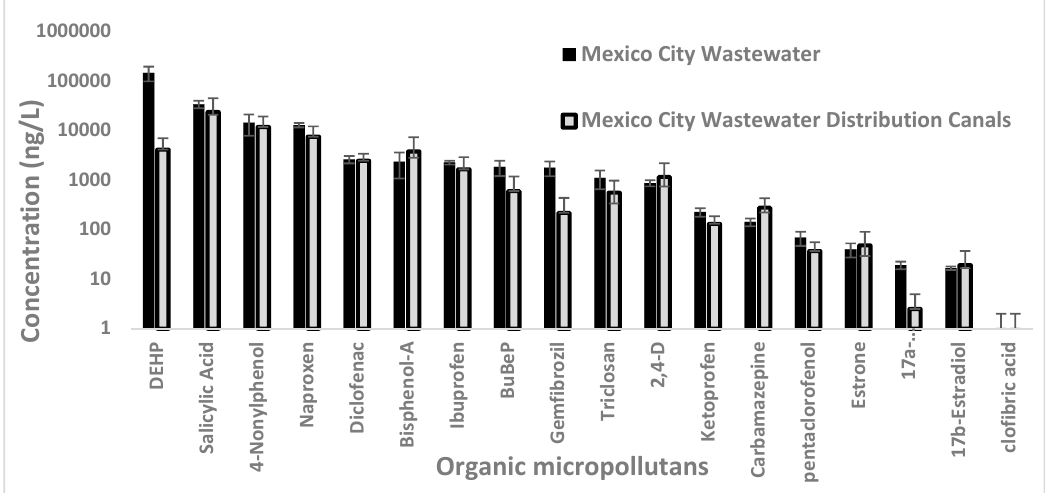
Figure 3. Presence of OMPs on wastewater in the distribution canals.